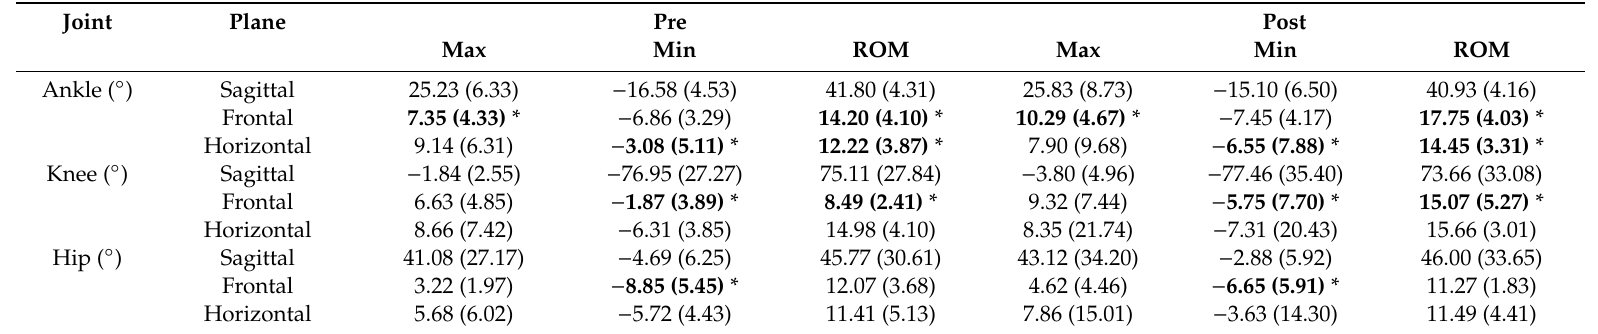
Table 3. Peak joint angles and ROM of pre-fatigue and post-fatigue during the landing